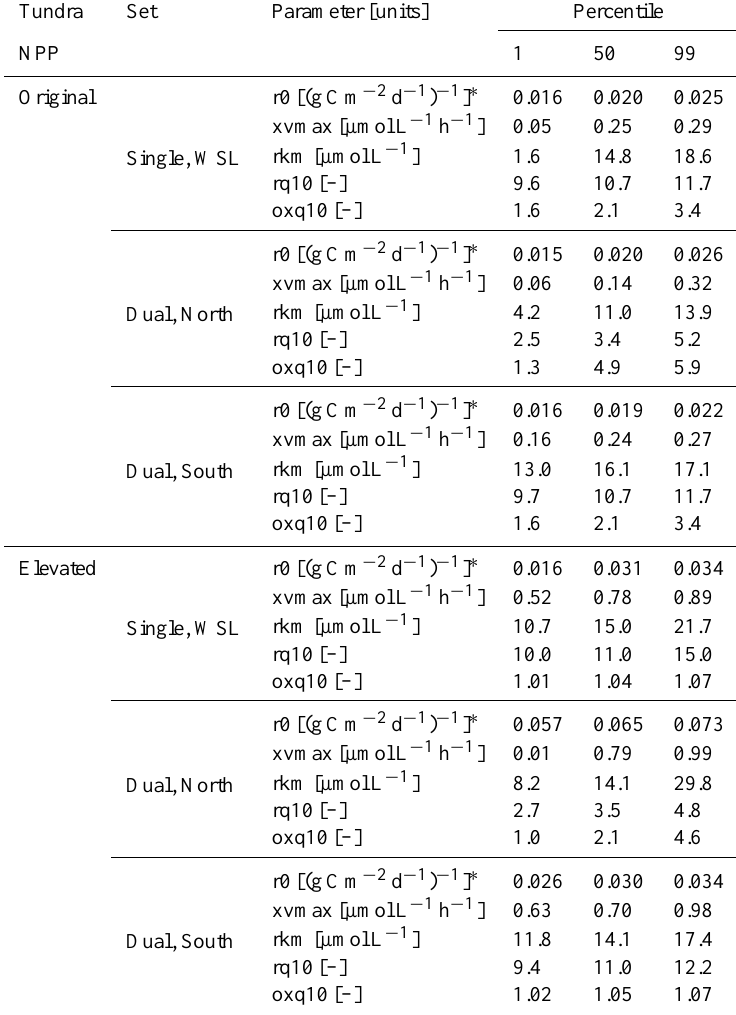
Table 3. Posterior distributions of calibrated methane emission parameters. Tundra Set Parameter